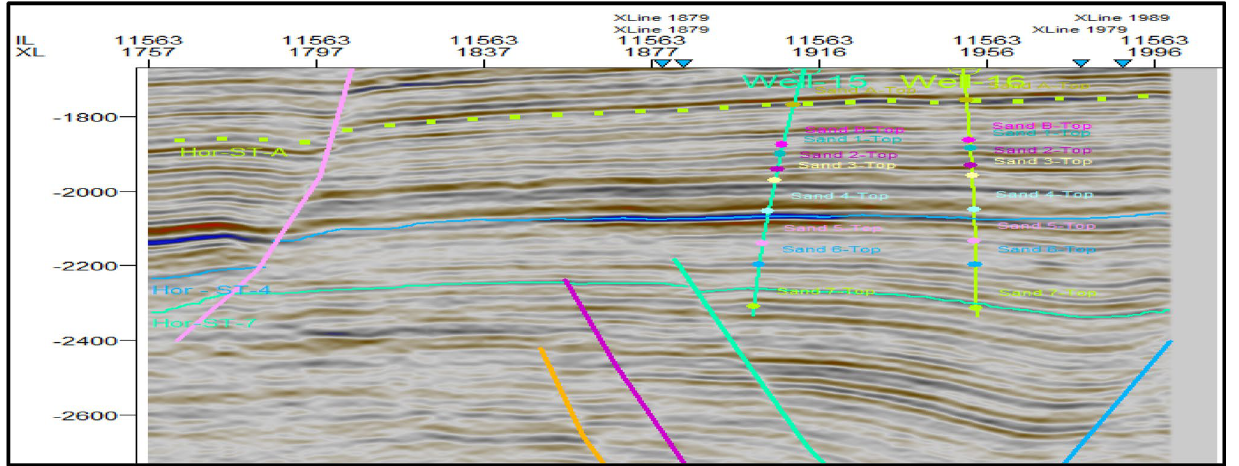
Fig. 7 Seismic cross section showing wells, faults and horizons